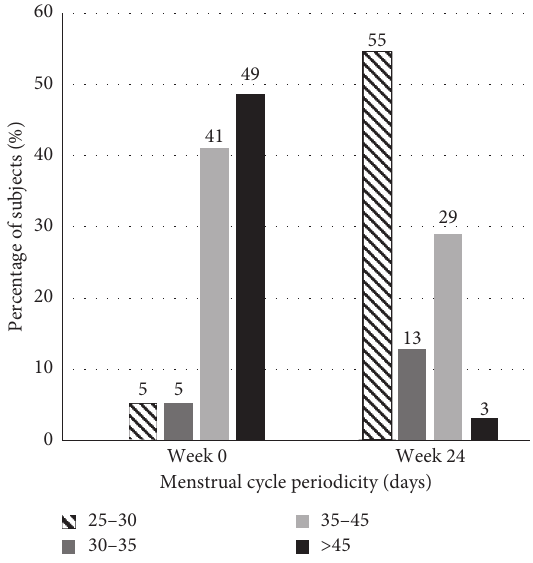
Figure 6: Distribution of menstrual cycle variation among the subjects during the study period. The different bar patterns rep- resent the menstrual cycle distribution in days among the patients having 25–30-day, 30–35-day 35–45-day, or > 45-day cycle, re- spectively. The enrolled patients displayed normal hormonal